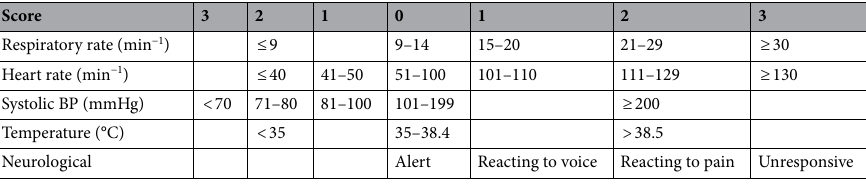
Table 3. Details of modified early warning